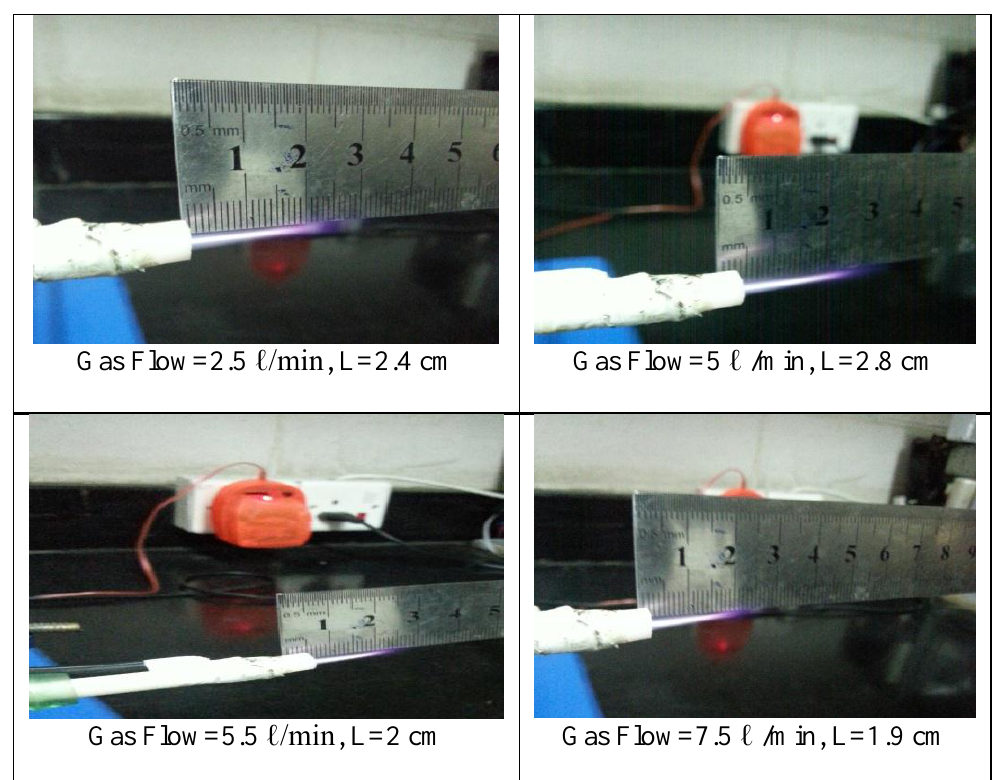
Fiq.2: The effect of argon flow rate on plasma jet